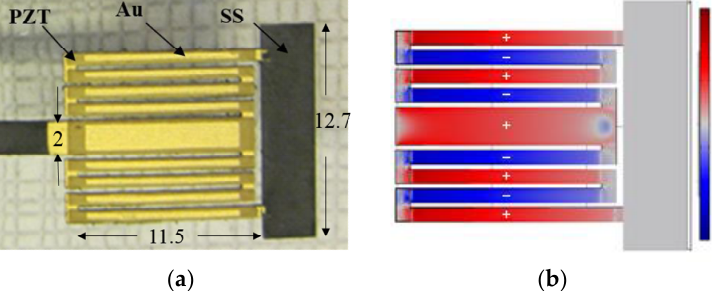
Figure 3. ( a ) Fabricated printed PZT energy harvester with Au electrodes (EH2 (dimension unit in mm)); ( b ) Strain contour plot showing tension (red) and compression (blue) in EH2. The structure of meandering PZT-based piezoelectric energy harvester (EH2) with a centrally-supported meandering geometry fabricated using screen-printing technology [28].